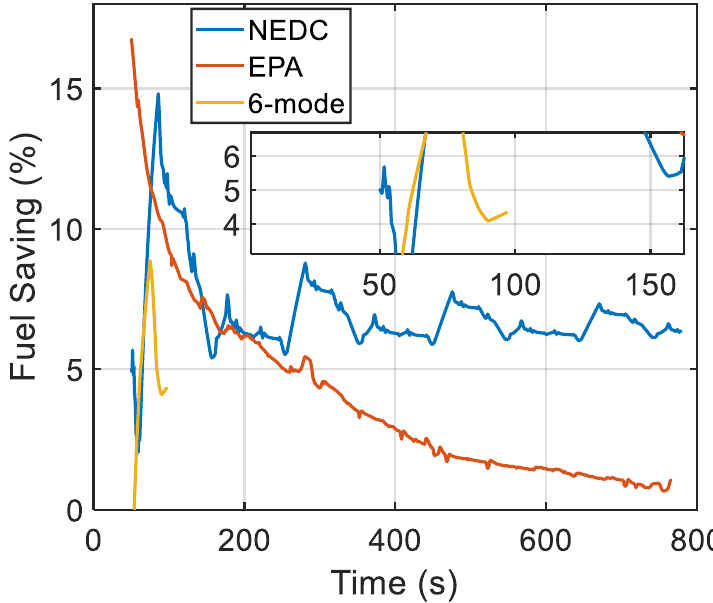
Figure 13. Comparison results of fuel saving during vehicle driving. Table 5. Economy comparison between HMCVT and